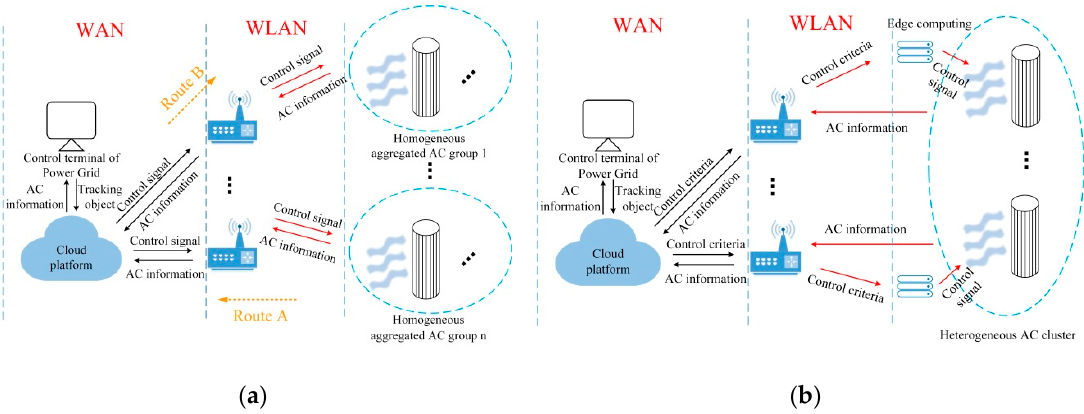
Figure 1. ( a ) AC (air-conditionings) group control structure based on cloud platform; ( b ) heterogeneous AC cluster control the structure based on cloud platform and edge computing.